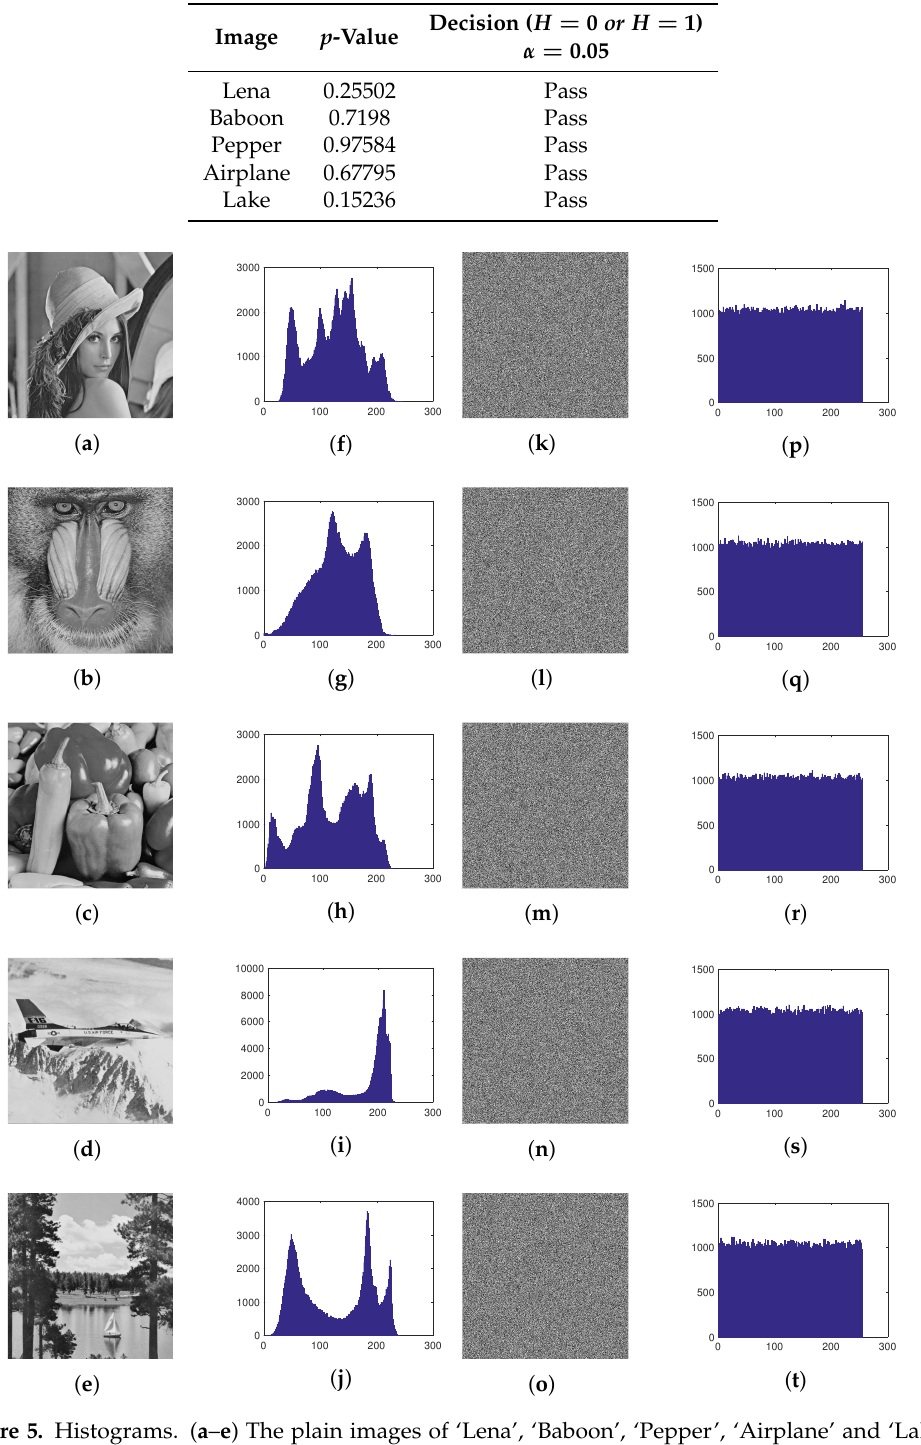
Table 6. Histogram uniformity evaluation by chi-squared test.